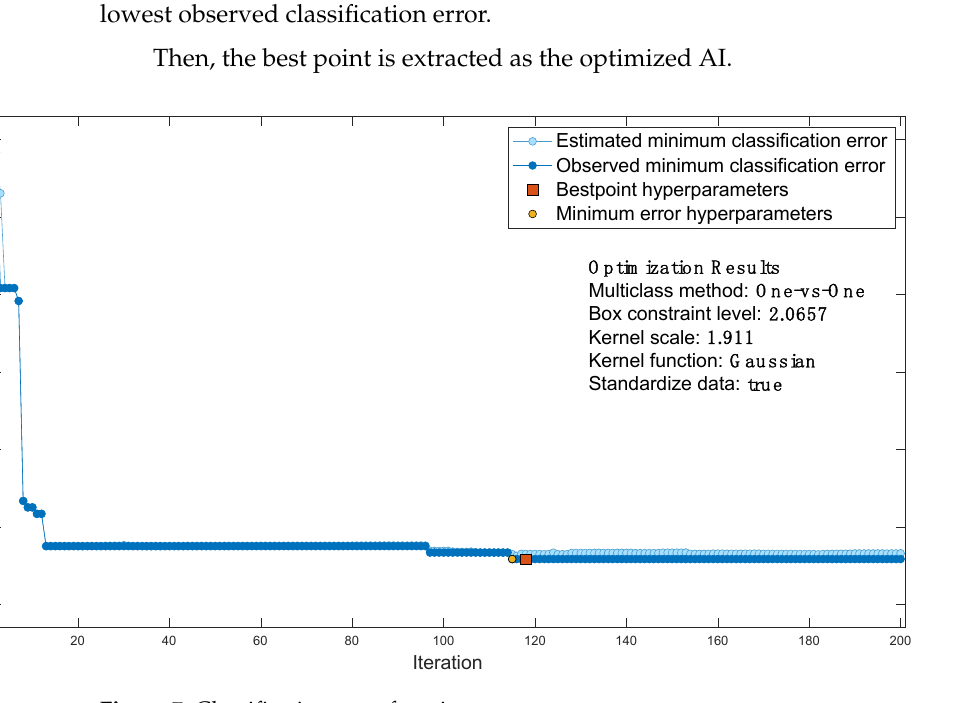
Figure 8. Confusion matrix. It is worth noting that a distinction should be made between the different types of errors: the error in the upper triangular matrix corresponds to an overestimation of the actual damage, which would lead to false alarms in real applications, while the errors in the lower triangular matrix are associated with an underestimation of the actual damage, which may lead to missed alarms. While these two types of errors are the same in terms of damage quantification, they can have very different consequences: a false alarm is costly because of the inconvenience it causes, while a missed alarm can jeopardize the safety of the work and people. Based on these considerations, it is interesting to define how to translate these technical observations so that AI can learn from them. The solution found is to insert penalties during the learning phase that limit the number of missed